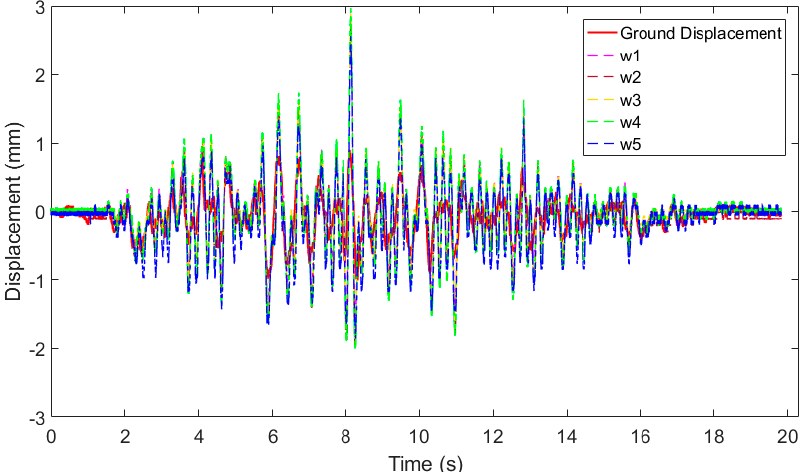
Figure 15. The peak value of the acceleration response for various seismic accelerations. ( a ) API and ( b ) RSN169_IMVPALL.